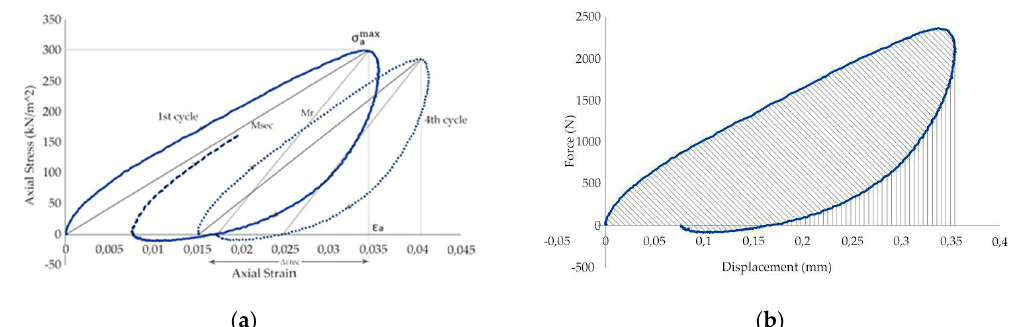
Figure 1. ( a ) Stress-strain response of the carpet-ceramic sand combination under load controlled cyclic loading when the first irregular cycle is subtracted. ( b ) Energy transformation in a loading cycle. The diagonally hatched area between the loading-unloading curves corresponds to the dissipated energy whereas the vertically hatched area refers to the recovered energy.